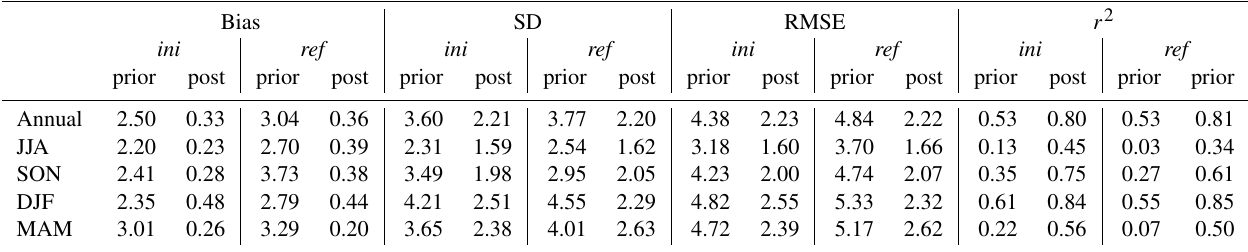
Table 2. Annual and seasonal bias, standard deviation (SD), root mean square error (RMSE) and coefficient of determination ( r 2 ) of prior model–data misfit and posterior model–data misfit for the initial inversion (experiment ini ) and the reference inversion (experiment ref ), respectively. JJA denotes July, August and September; SON September, October and November; DJF December January and February; MAM March, April and May. All values, except for r 2 , are given in